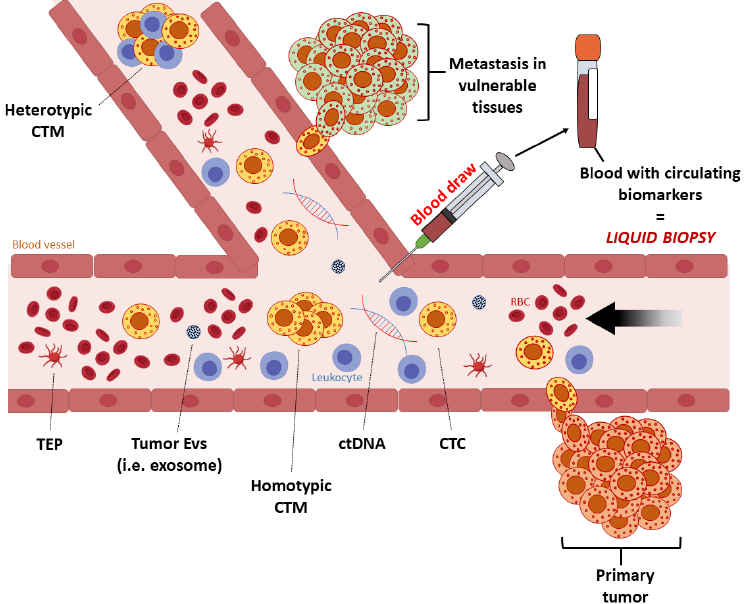
Figure 2. A schematic of liquid biopsy in a patient with a solid tumor. Tumor cells circulate in blood, with those that are more aggressive (metastasis-initiator cells) settling in targeted distant organs and initiating metastasis. Blood collected from cancer patients contains circulating tumor cells (CTCs), clusters or circulating tumor microemboli (CTM), proteins, circulating cell-free tumor DNA (ctDNA), extracellular vesicles (EVs), such as exosomes, and tumor educated platelets (TEPs). These complementary circulating biomarkers can be detected and provide real-time information on tumor progression, prognosis, and treatment response. Abbreviations: CTCs, circulating tumor cells; ctDNA, circulating tumor DNA; CTM, circulating tumor microemboli.